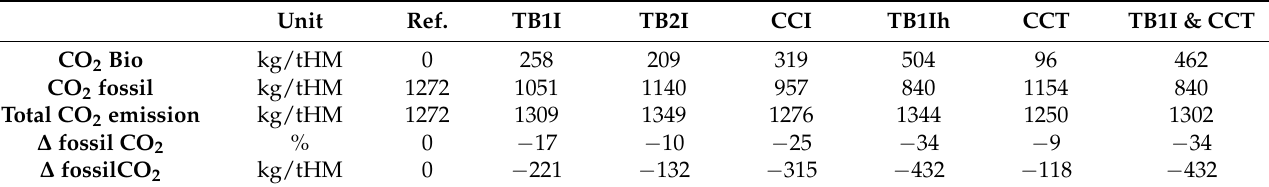
Table 4. CO 2 emissions and comparison with reference case.